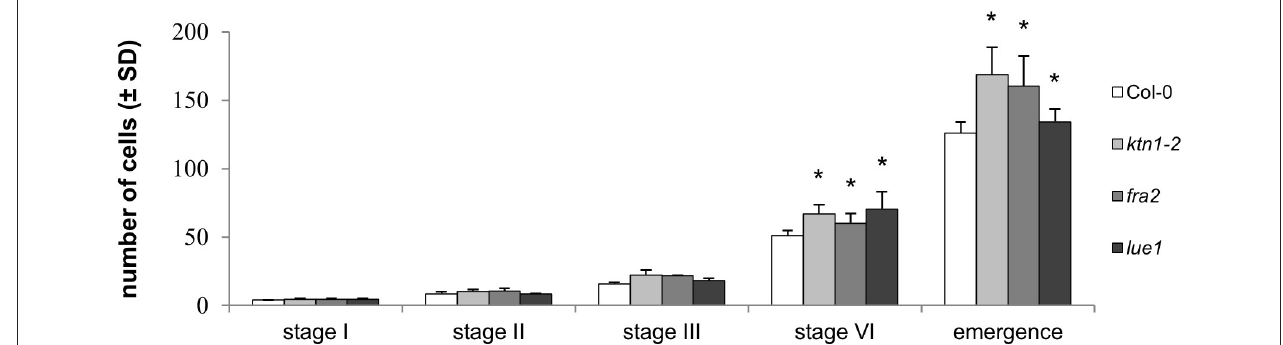
FIGURE 7 | Number of cells in different stages of lateral root primordia development in Col-0 and katanin1 mutants. Number of cell in individual developmental stages of lateral root primordia in 7 days old seedlings showing comparison between Col-0, fra2 , lue1, and ktn1-2 mutants. Calculations are based on data collection from 8–9 seedlings. Asterisks indicate statistical significance between measurements (* p <